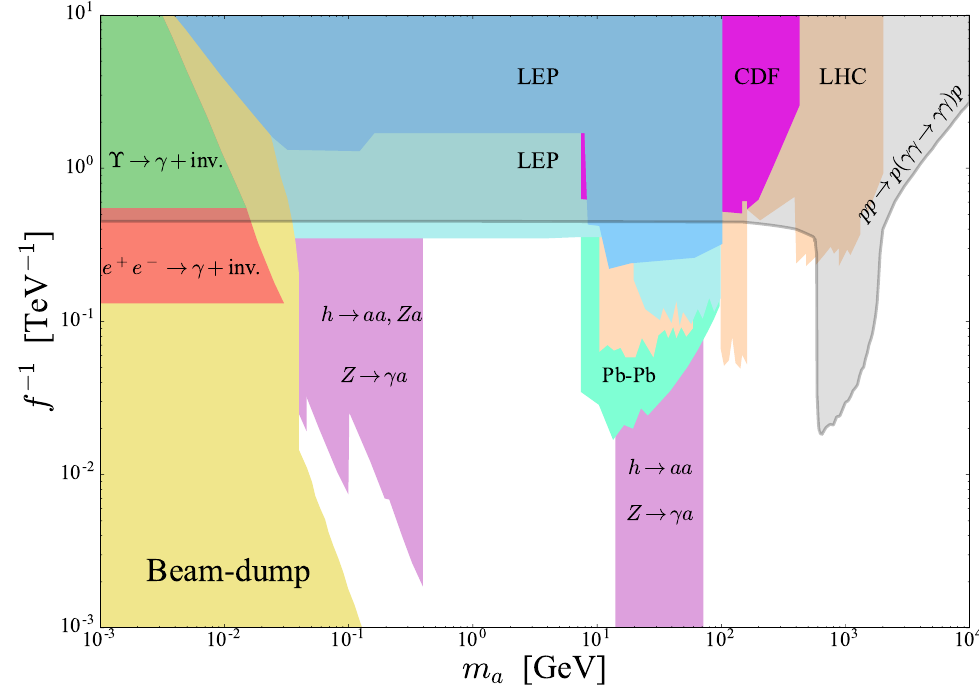
Figure 6 . Exclusion regions on the ALP-photon coupling f (cid:0) 1 and mass of the ALP m a plane. On light-shaded grey, we have the expected 95%CL exclusion limit in central exclusive diphoton production events assuming B ( a ! (cid:13)(cid:13) ) = 1 for 300 fb (cid:0) 1 in Run-2 of the LHC. Existing bounds are in solid color, are extracted from ref. [13], and can depend on additional assumptions (see text for